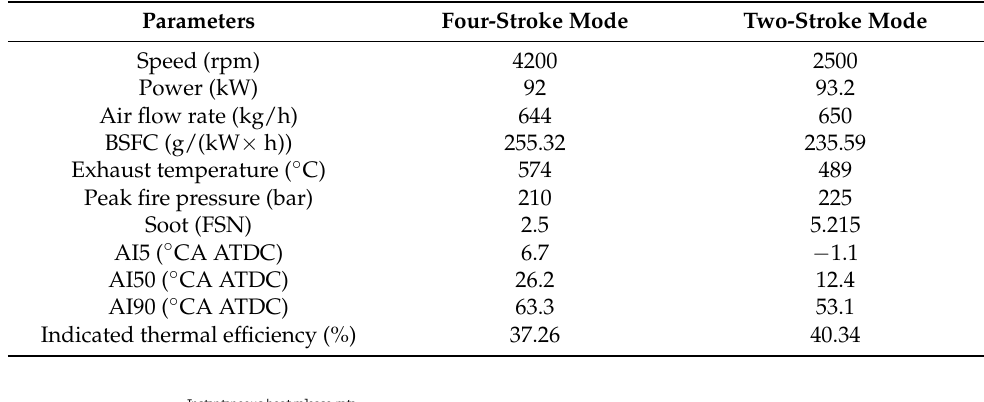
Table 18. Engine test data.